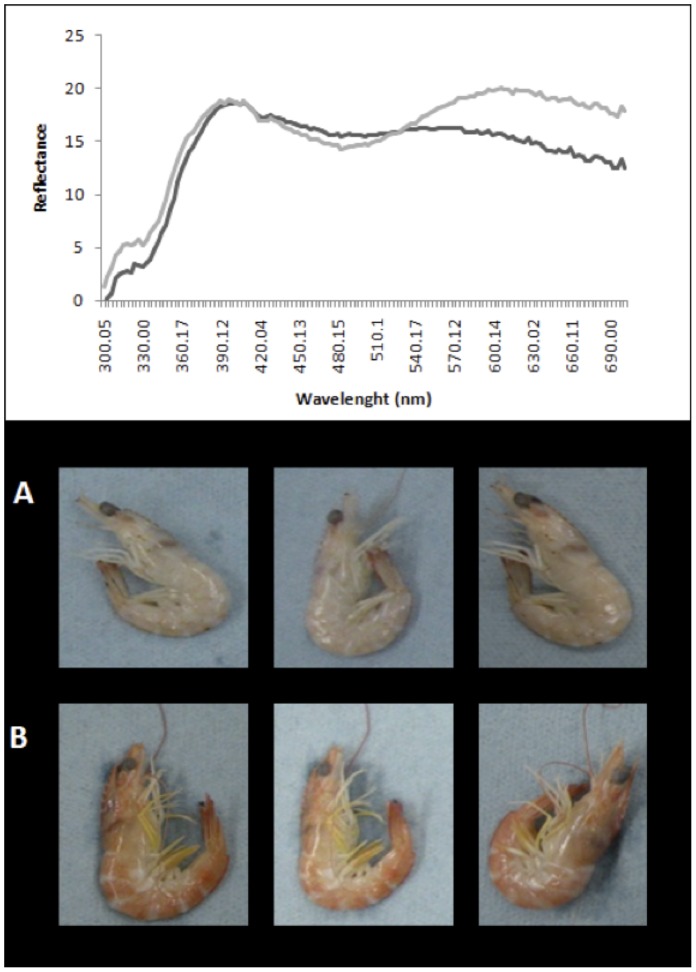
Color of shrimps.Reflectance spectra for head coloration in control (black line) and experimental (grey line) shrimps. Visual aspects of selected shrimps not exposed (A) and exposed (B) to 1 mg/L of Cu during 9 days are shown in the image, in order to highlight the effect.